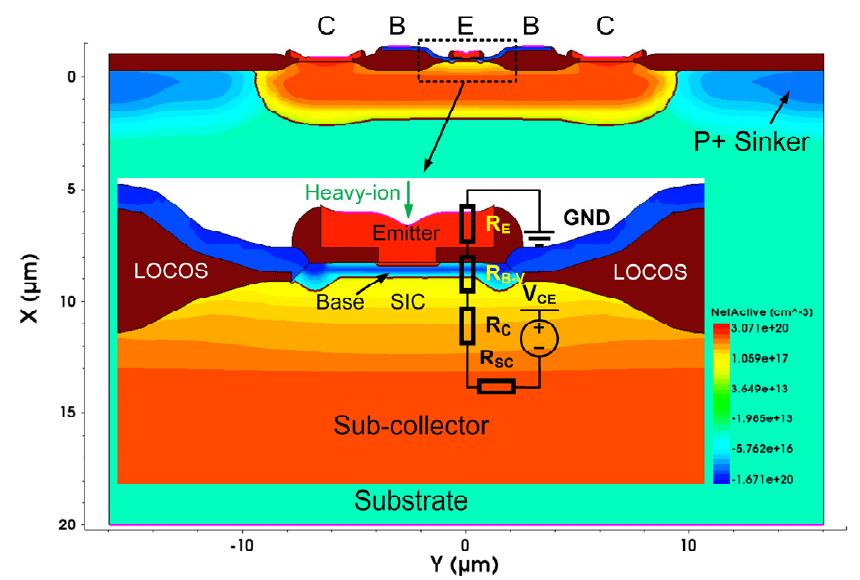
Figure 3. The 2-D TCAD process model with 1E2B2C structure and the inside zoom view shows the parasitic resistance of the E/B/C stack when the ion shunt effect is triggered.